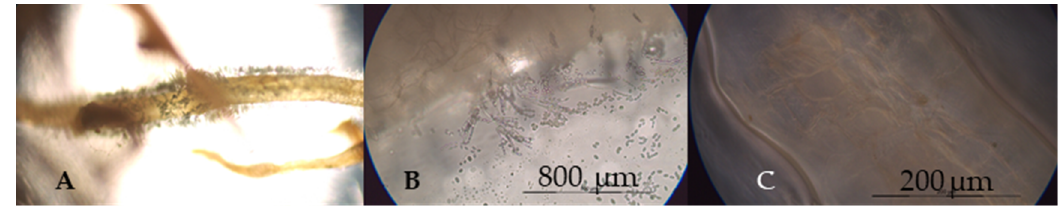
Figure 5. P. variotii mycelium and conidiophores colonizing tomato ( A : 100×; B : 200×) and pepper roots ( C : 400×).